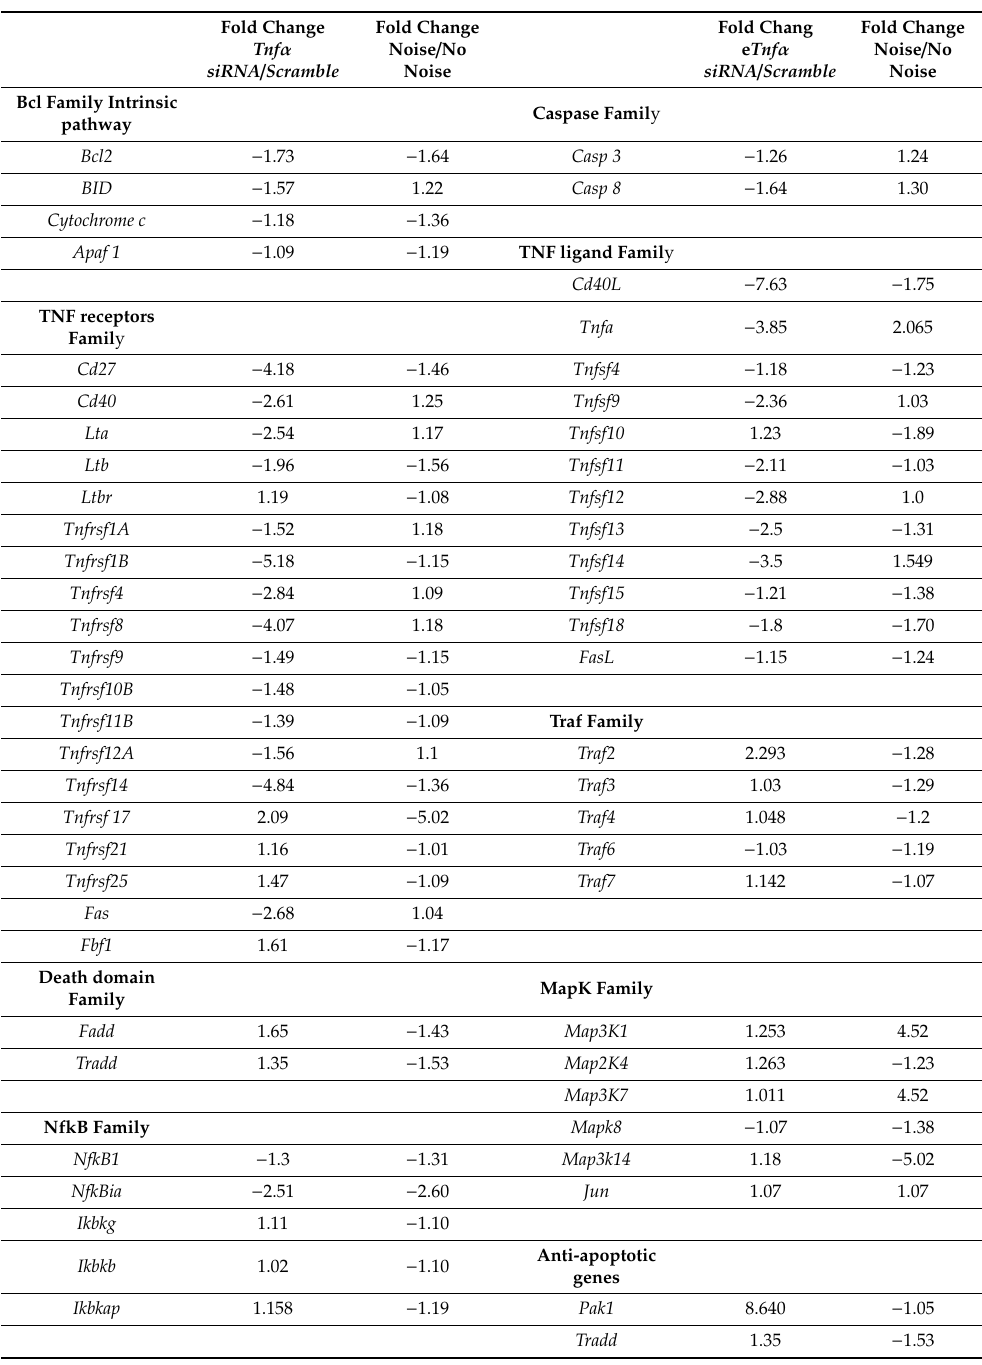
Table 1. Description of the grouping of the genes analyzed in the TNF α metabolic pathway performed by qRT-PCR analysis in the cochleae of rats previously submitted ( n = 20) or not submitted ( n = 20) to Tnf α siRNA administration and after noise exposure, in their respective families. In addition, the fold changed values of siRNA Tnf α / scramble, as well as of noise / no noise is shown. Higher and lower gene expressions in the fold changes of siRNA Tnf α / scramble were determined by the cut-o ff defined at 1.2657. Samples were normalized with the Gadph, Hmbs, Actb, and 18S genes. Abbreviation: B-cell CLL / lymphoma 2 (Bcl), Mitogen-activated protein kinase (Mapk), TNF receptor associated factor (Traf), Nuclear factor kappa-light-chain-enhancer of activated B cells ( NfkB